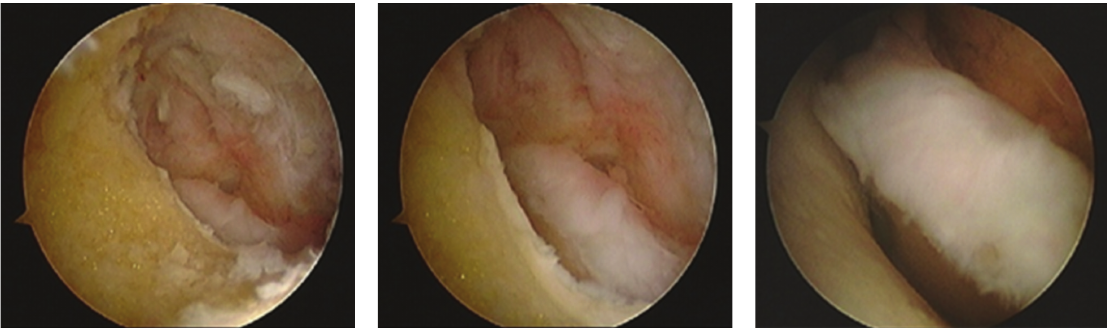
Figure 3: Intraoperative images of the perforated humerus (seen from the posterior compartment with a view on the anterior compartment of the joint) demonstrating the free movement of the coronoid process in the created